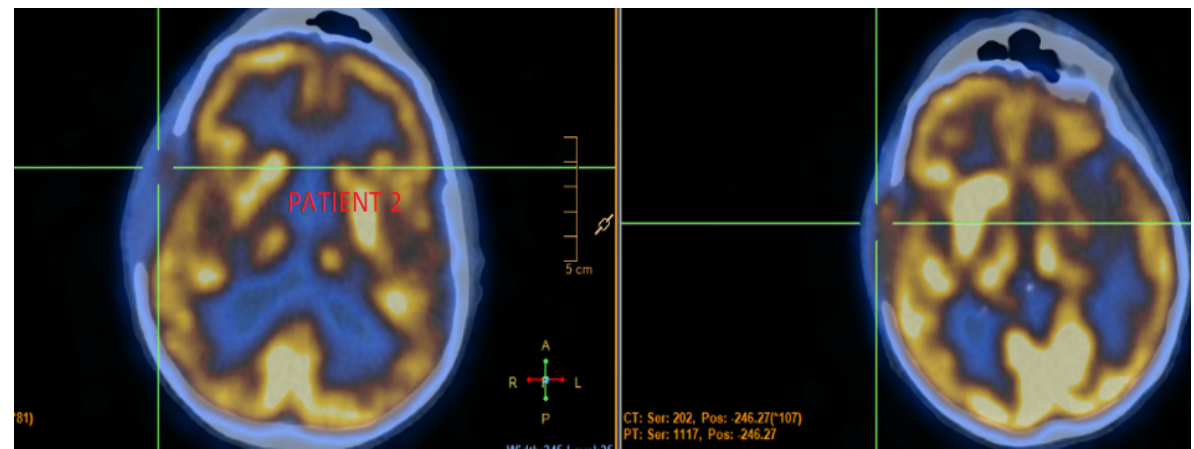
Figure 2. The patient’s response to lenvatinib treatment for bone disease as shown on FDG PET/CT scan.